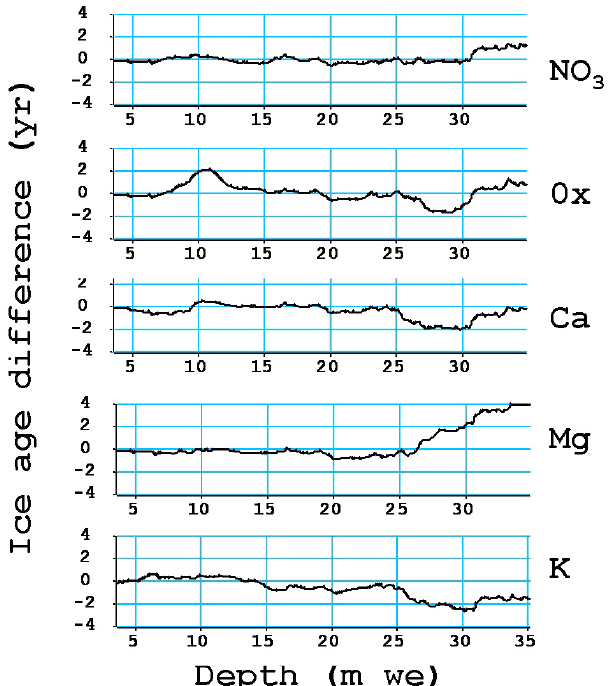
Figure 14. Ice age differences (yr) calculated for the 36 upper metres (mwe) between the chronology given by de Angelis et al. (2003) and chronologies deduced from nitrate (NO 3 ), oxalate (Ox), calcium (Ca), magnesium (Mg), and potassium (K) concentration profiles (from top to bottom, respectively).